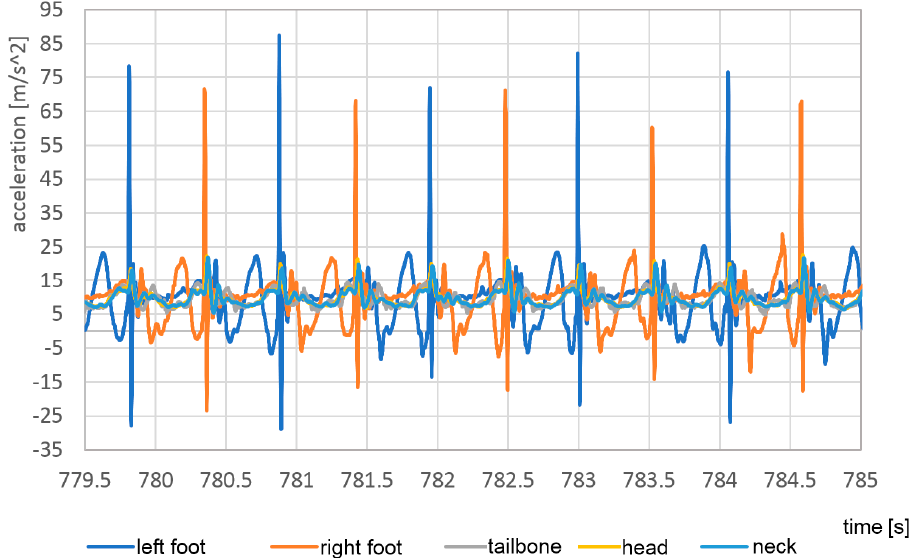
Figure 25. Vertical component of acceleration of each sensor during the passage with bare feet.